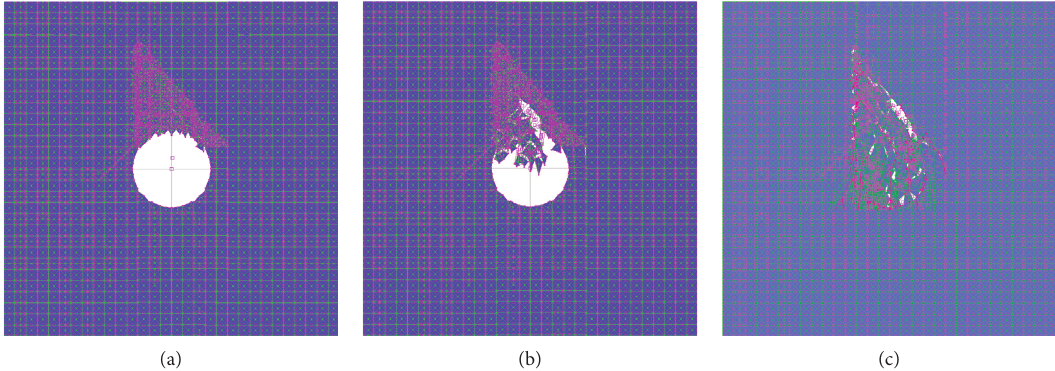
Figure 7: The evolution process of the 11.28 rockburst at different steps: (a) 150th step. (b) 1560th step. (c) 2590th